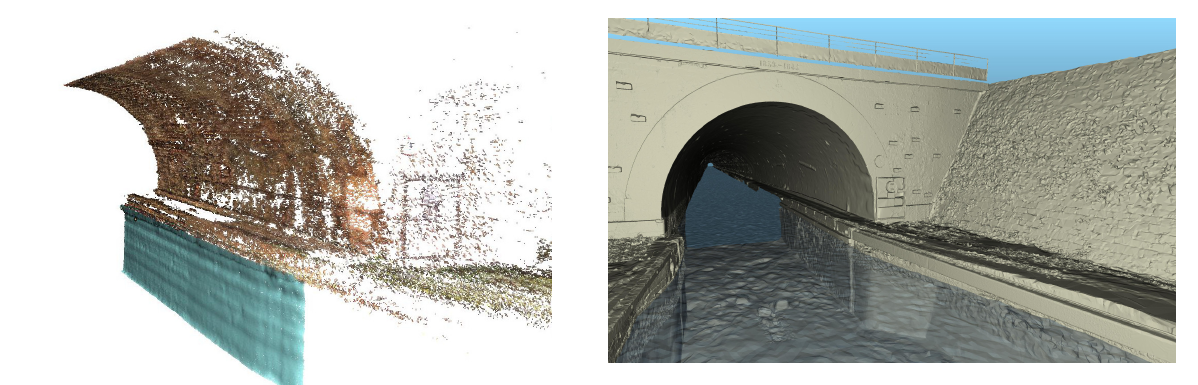
Figure 12. 3D reference model of Niderviller tunnel Figure 11. Part of the final model resulting from the developed approach.